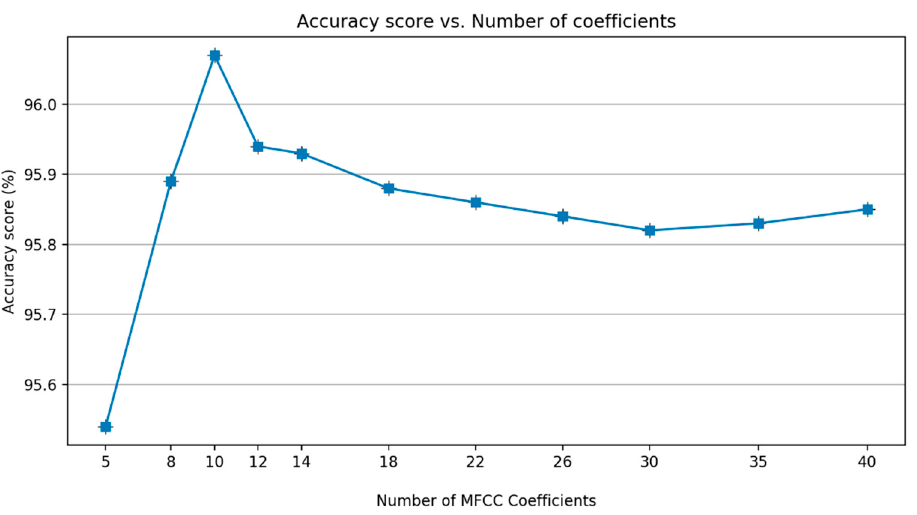
Figure 9. A comparison of the number of MFCC coefficients.